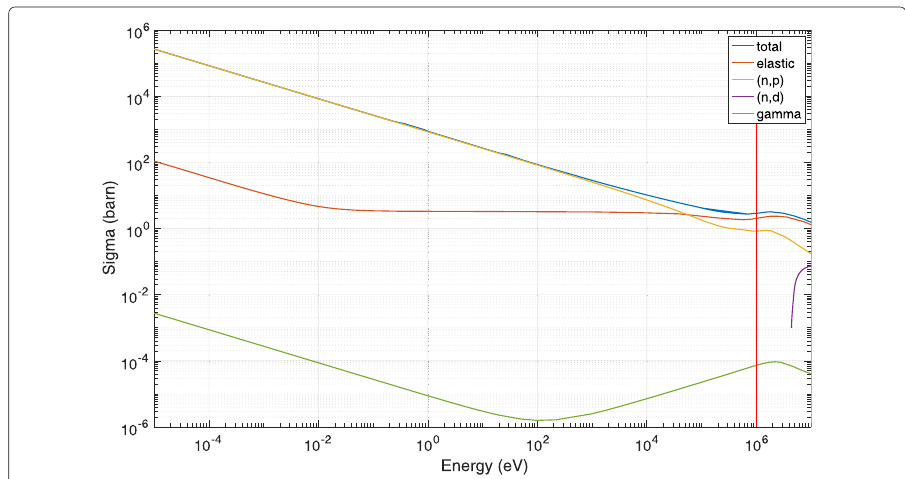
Fig. 2 Neutron cross section of 3 He in the energy range 0-10 MeV for the 4 reactions: 3 He recoil, (n,p), (n,d) and γ -rays. The total cross section is shown as well. Data from [44]